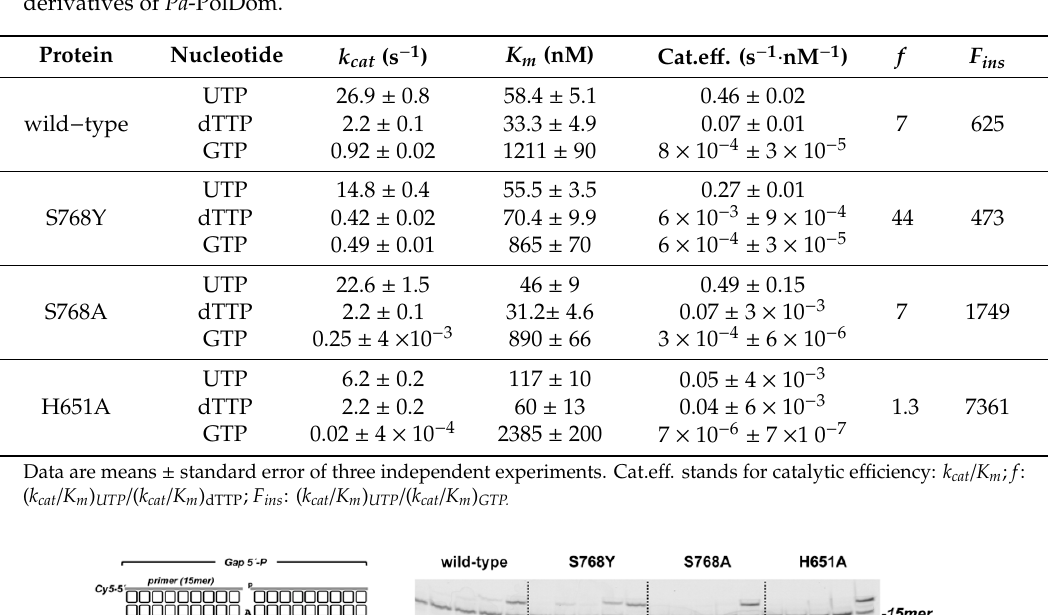
Table 1. Steady-state kinetic parameters of nucleotide incorporation by wild-type and mutant derivatives of Pa -PolDom.